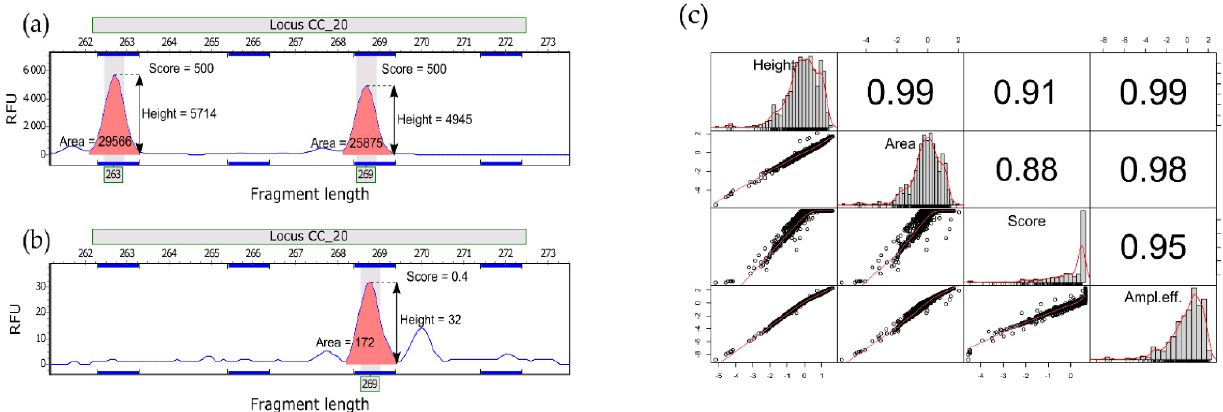
Figure 2. ( a , b ) Two electrophoresis profiles showing the peak variables used in this study. ( a ) sample (heterozygote) characterised by higher quality score ( b ) sample (homozygote) with poorer quality peak. The vertical axis is in relative fluorescence units (RFU) and the horizontal axis is in base pairs. ( c ) Correlations between the three peak variables and amplification efficiency—an additional variable computed as the first principal component (PCA) from these three variables to be used as a single dependent variable in regression analysis. All correlations significant at p < 0.001.